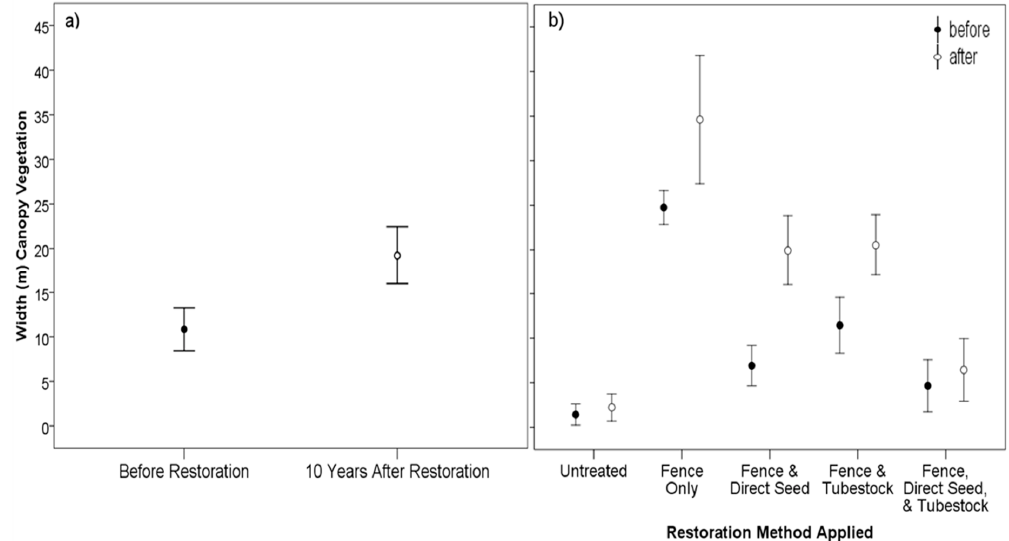
Figure 4. Change in width of canopy vegetation from aerial photographs of sites before restoration occurred and 10 years after. Width of canopy vegetation ( a ) across all treated sites and, ( b ) for untreated sites and sites restored using each of the four restoration methods. Closed circles ( ● ) = before restoration, and open circles ( ○ ) = 10 years after restoration. Error bars represent ± SE.